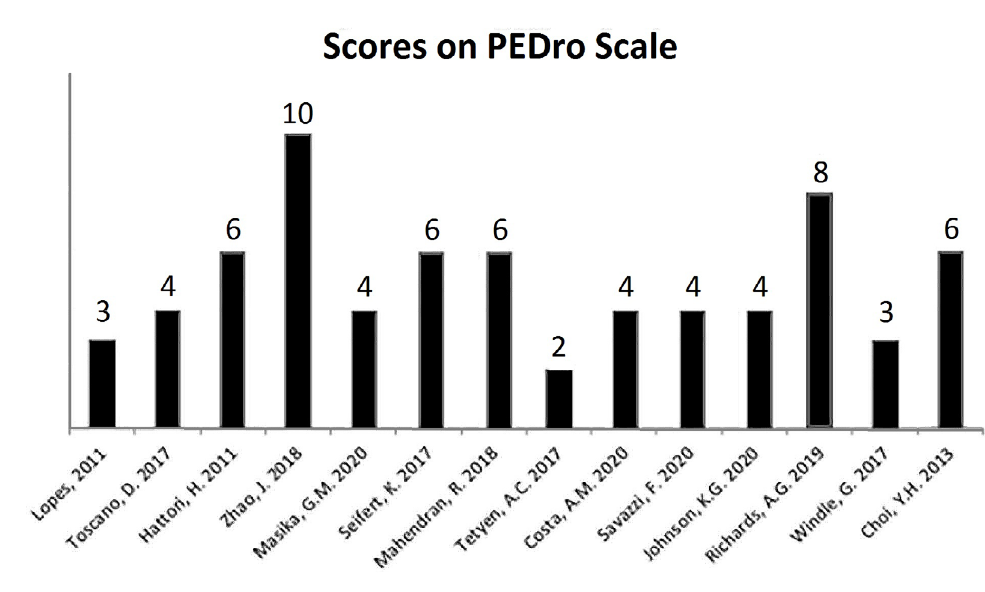
Figure 2. Percentage obtained using the PEDro Scale for the selected